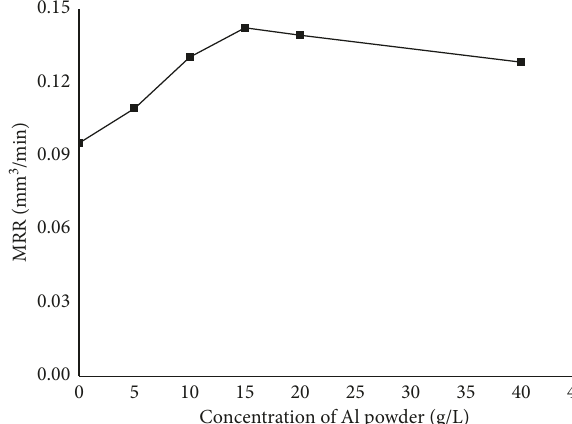
Figure 12: Material removal rate versus the concentration of Al powder.